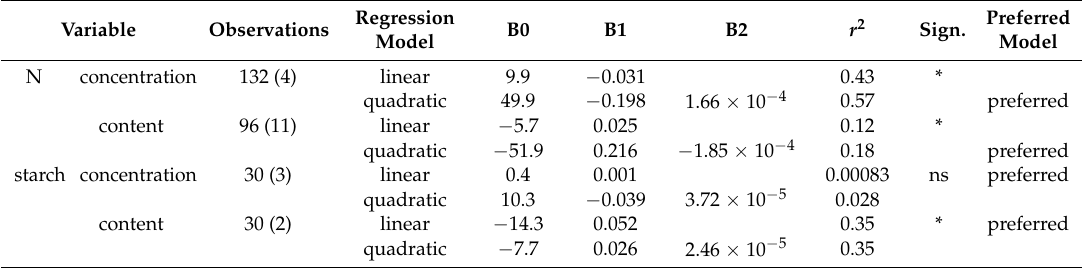
Figure 1. ( a ) Meta-analysis of eCO 2 effects on N concentration and N content using ambient CO 2 as the reference, with subgroup-analysis of exposure systems, rooting environment, and concentration level for eCO 2 treatment. Number of comparisons for concentration and content, respectively, are given within brackets. ( b ) Response function for N concentration (relative to 350 ppm) with CO 2 concentration, grey markers show data points identified as outliers not included in the curve fitting. Table 1. Response functions for regression of concentration (mg·g −1 ) and content (g·m −2 ) of N, starch, and minerals with CO 2 .